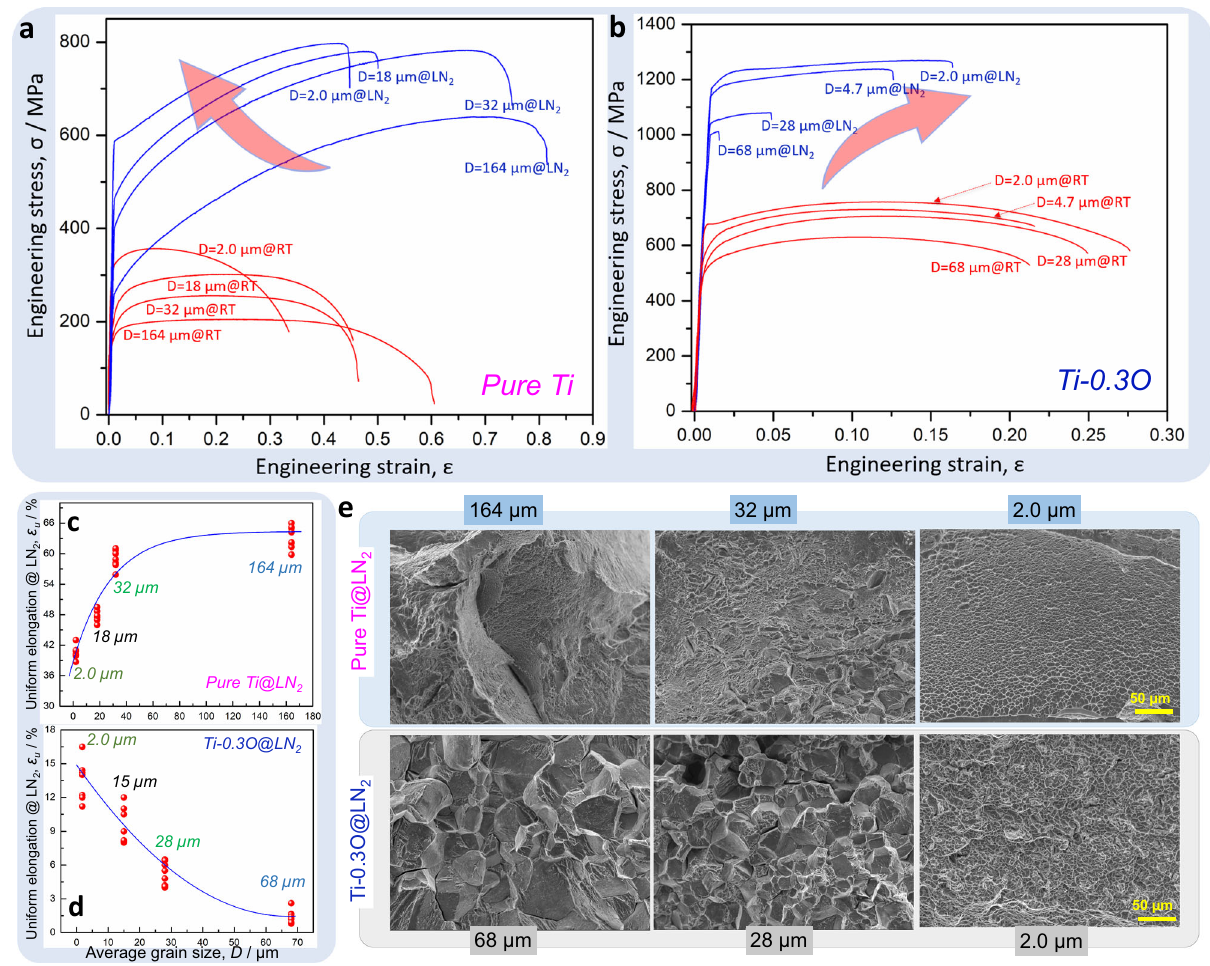
Fig. 2| MechanicalpropertiesofpureTi andTi-0.3Oalloyswithdifferent grain sizes. Engineering stress-strain curves of pure Ti a and Ti-0.3O b with different grainsizesatroomtemperature(redcurves)andliquidnitrogentemperature(blue curves). Note the different strain regimes (on the x-axis) for the two alloys. The